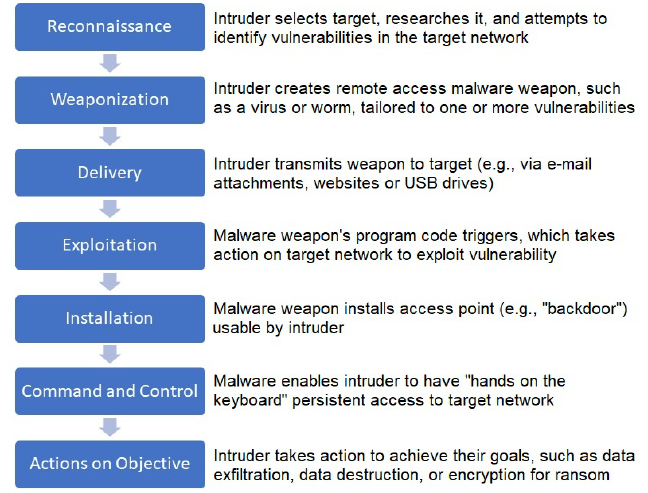
Figure 2. Cyber Kill Chain is a cybersecurity model that discovers the phases of a cyber attack, recognizes vulnerabilities, and supports security people to encounter the attacks at every step of the chain.